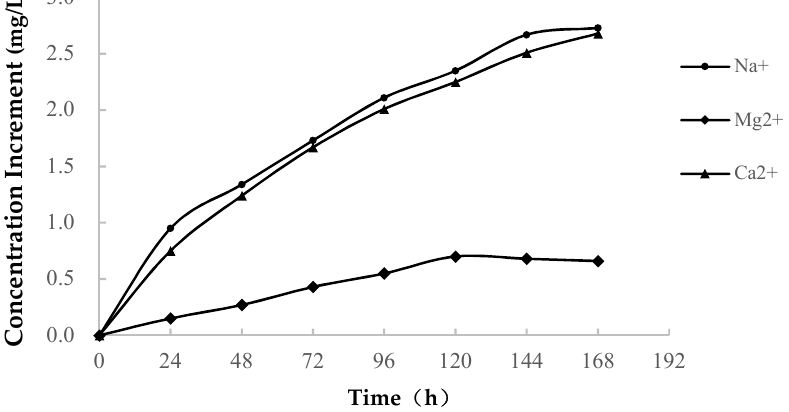
Figure 5. The change curve of the ion concentration in each 0.1 mol / L solution.